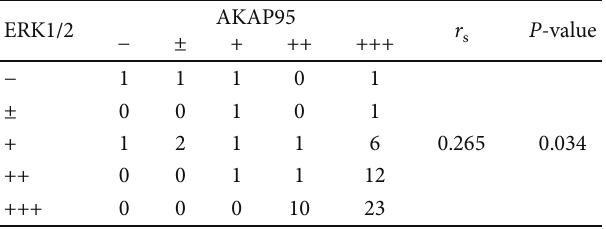
Table 3: The relationship between AKAP95 and ERK1/2 protein expression in colon cancer tissue.